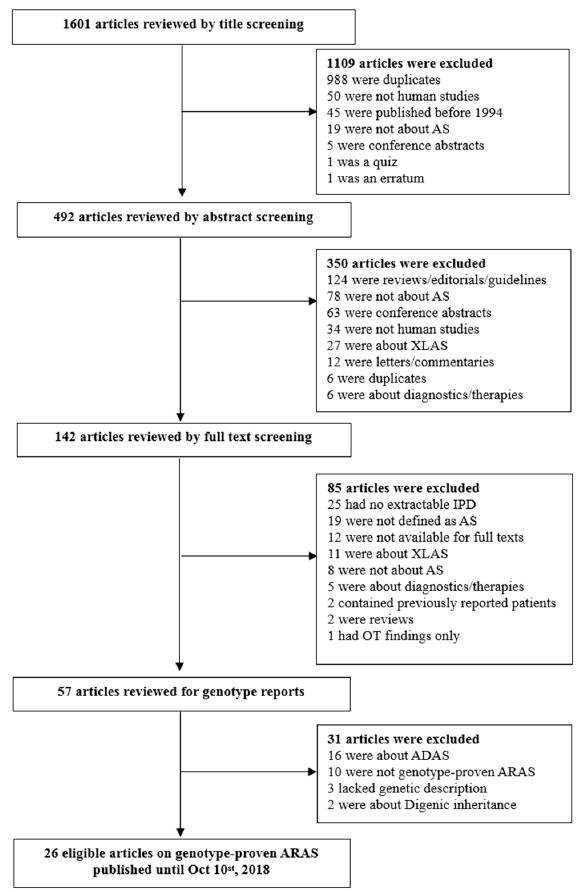
Figure 1. Flow chart of Literature search. AS, Alport syndrome; XLAS, X-linked AS; ADAS, autosomal dominant AS; ARAS, autosomal recessive Alport syndrome; IPD, individual patient data.